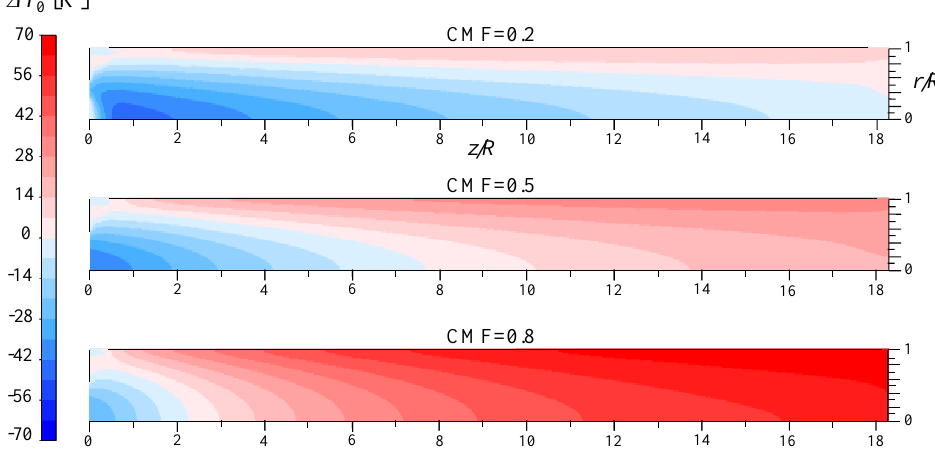
Figure 4. Total temperature difference contours for different cold mass fractions.